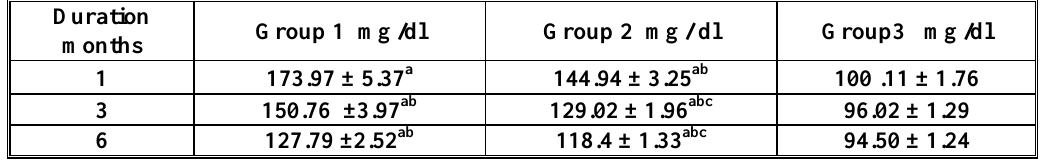
Table 1: Effect of treatment with metformin 500 mg 3 times daily + glibenclamide 5 mg twice